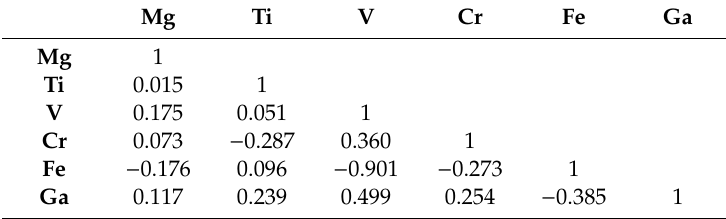
Table 2. Correlation table for trace elements of Thai / Cambodian Sapphires.